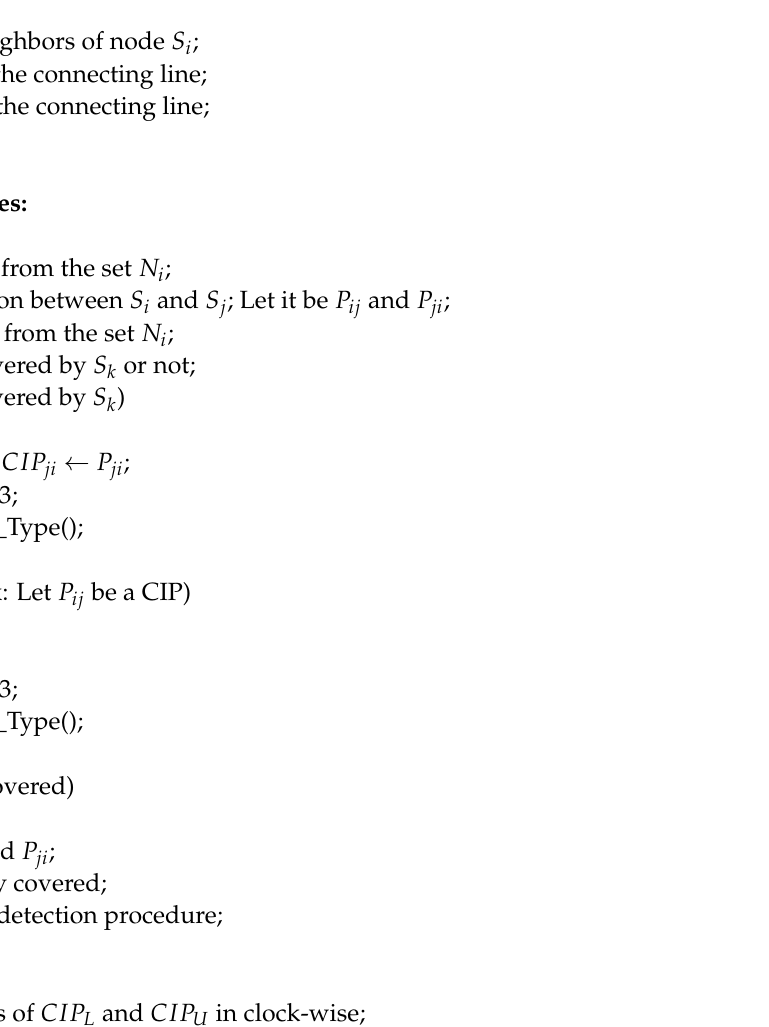
Algorithm 4 Distributed coverage hole detection (DCHD)